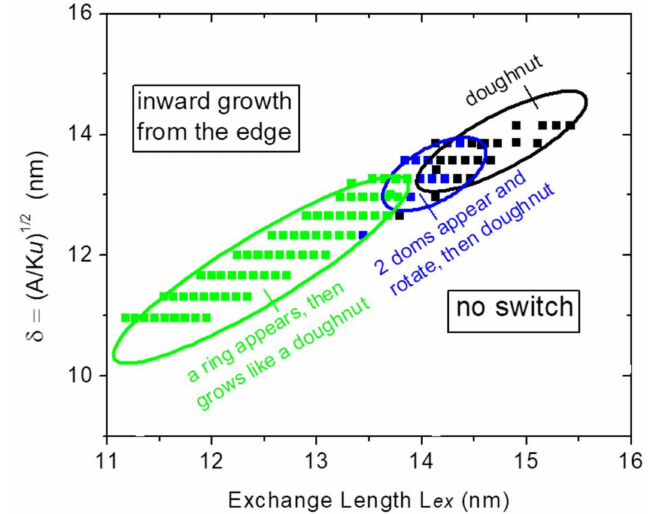
Figure 10. This figure shows the result of calculations for the rotations observed within the domain patterns in Figure 9. There are size limits that permit polarization switching, typically between 12 and 15 nm. These size limits may be compared with those in the more recently discovered vortex arrays [39,40]. The size limits remind us that the circular boundary conditions of our disc-shaped ferroelectric films are very important, and the bull’s eye spatial patterns (Figures 7d and 8a) approximate first-order Bessel functions (standing waves on a drum head